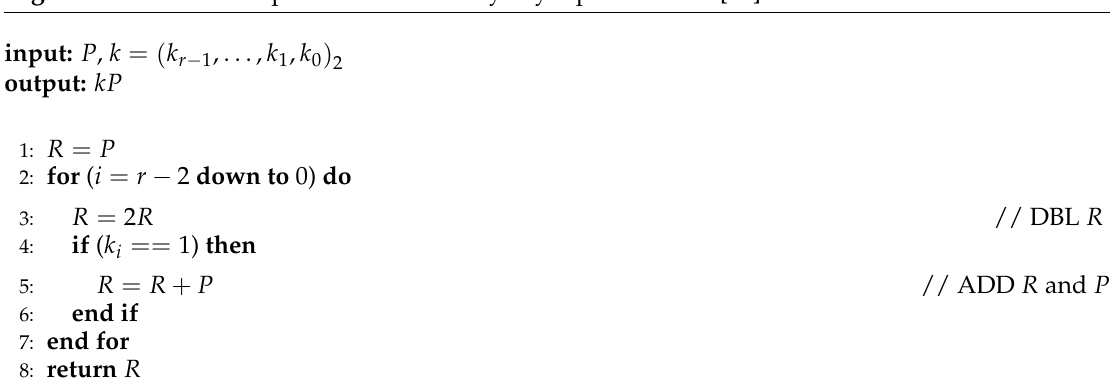
Algorithm 1 Point multiplication with binary key representation